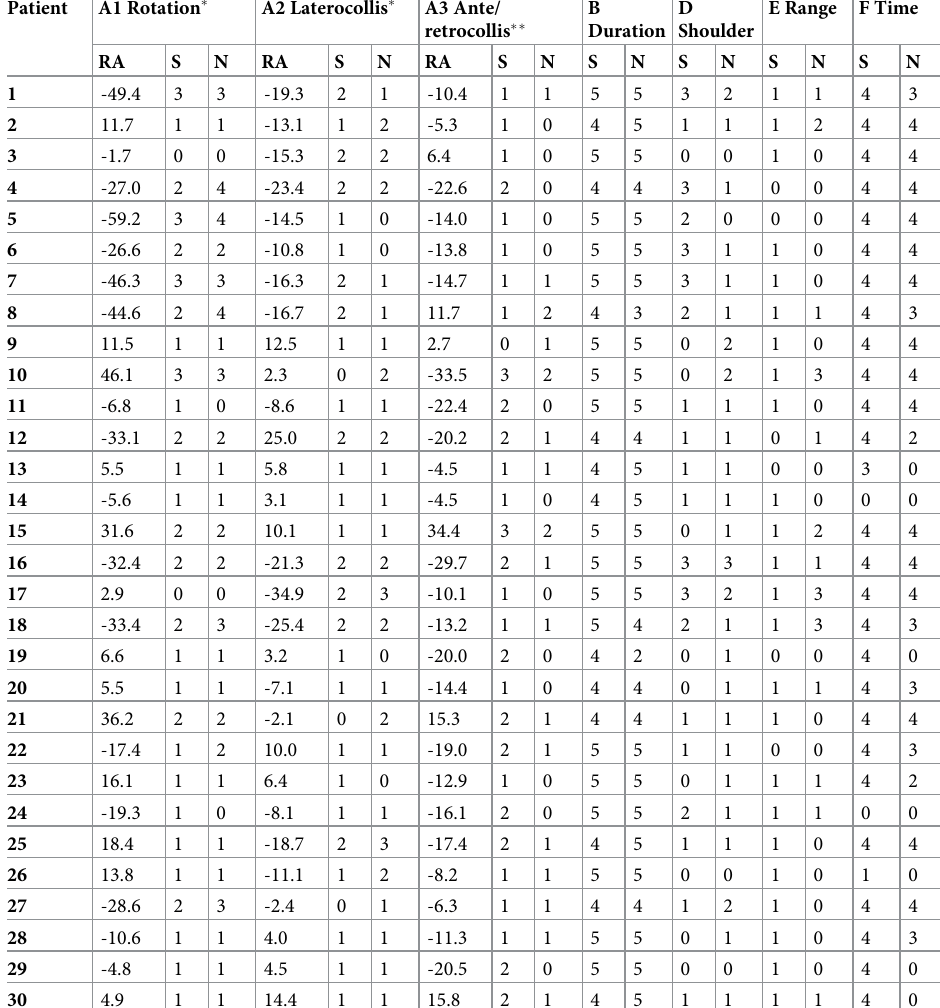
Table 2. Raw score of the automated parts of the TWSTRS severity scale calculated by the system vs. score obtained by a